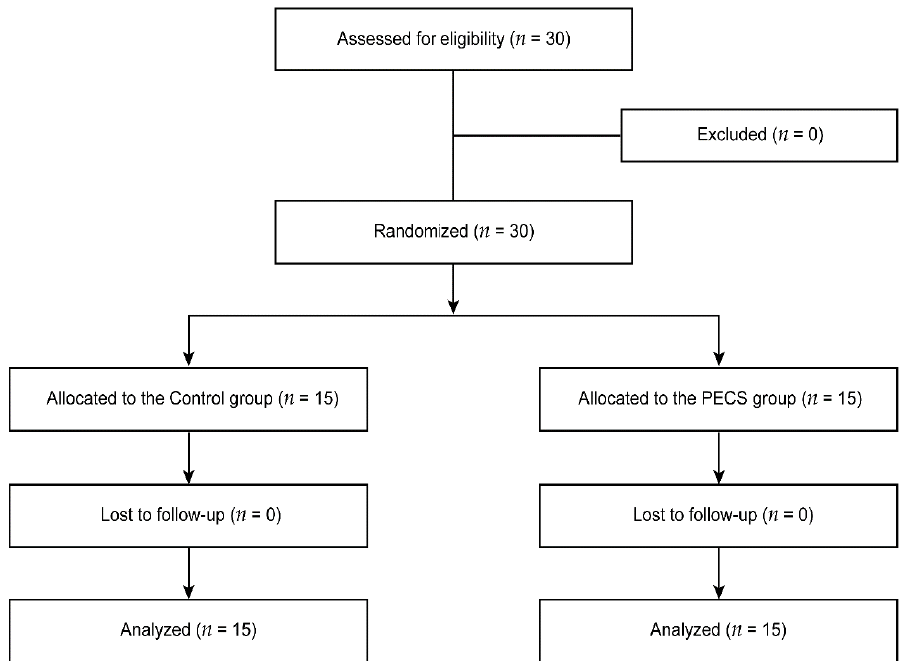
Figure 1. Consolidated Standards of Reporting Trials flow diagram. PECS, pectoralis nerve II block.